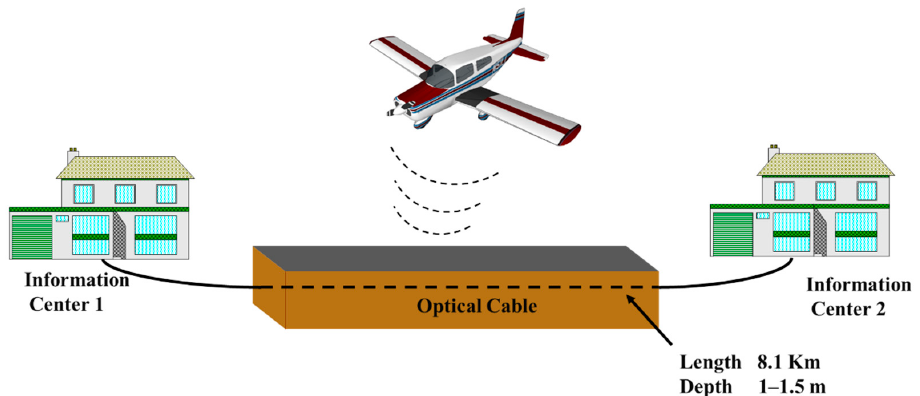
Figure 2. The experiment scenario.